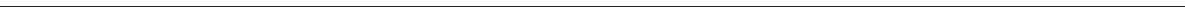
FIGURE 3 | from WT and Ncf1 − / − mice were stimulated with H. capsulatum (MOI = 5) for 1h. Cells were fixed and stained for LC3B (green), F-actin (red), and the nucleus compartment (blue). Cells were viewed under confocal microscope. Asterisks in the DIC/Nucleus image point to H. capsulatum yeasts. The intensity of different fluorochromes along the white arrow in the merged image is shown as histogram on the right. The mean fluorescence intensity (MFI) of LC3 in cells engulfing H. capsulatum was quantified. Phagosomes in each cell were counted and the percentages of LC3 + phagosome are shown as mean ± SEM of 4 independent experiments. (G) Macrophages from WT and Ncf1 − / − mice were allowed to phagocytose FITC-labeled H. capsulatum (MOI = 10) for 1h. Percentages of cells taking up H. capsulatum were analyzed by flow cytometry. Mean ± SEM are shown ( n = 4). * p ≤ 0.05, ** p ≤ 0.01, *** p ≤ 0.001 [ANOVA with Tukey post-hoc analysis (B,C) or Bonferroni’s multiple comparisons post-hoc test (D) ; 2-tailed t -test (F,G)